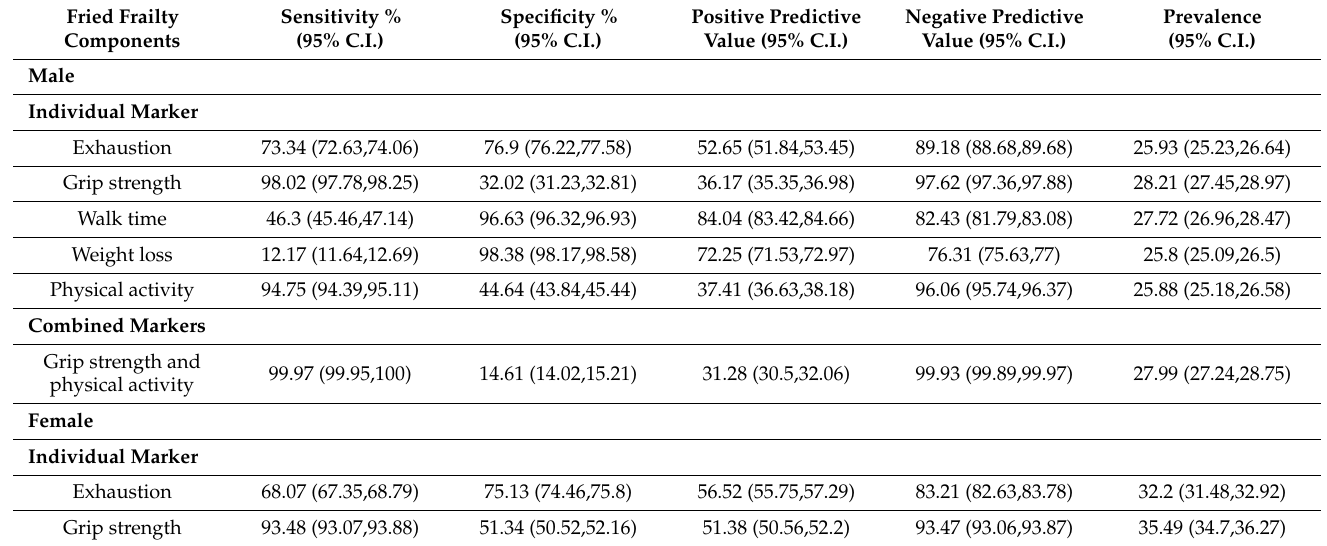
Table 3. Gender-specific diagnostic accuracy of the Fried frailty phenotype components in